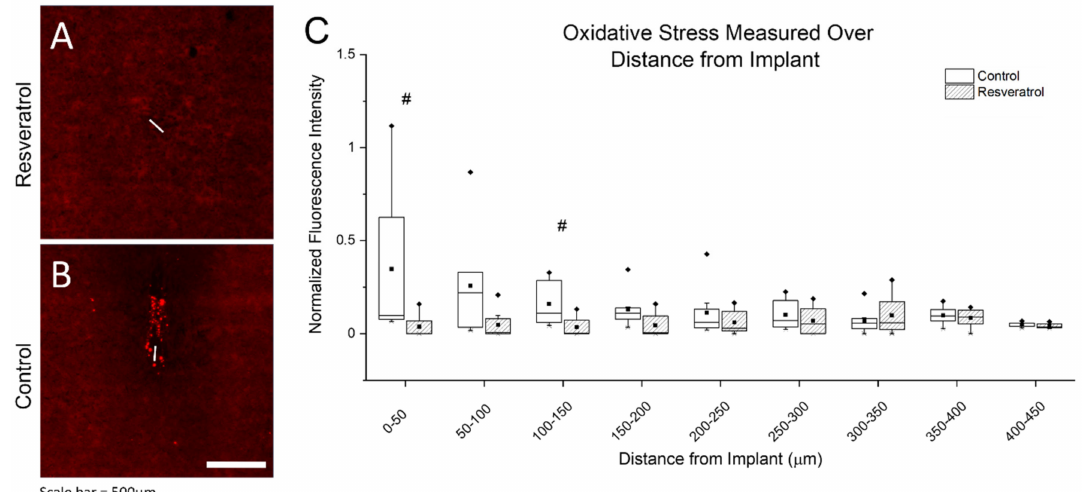
Figure 5. Oxidative stress as measured through protein damage. Representative image of oxidative stress as depicted by oxidized proteins ( A , B ), and normalized fluorescence intensity of analyzed images in bins of 50 mm distances from the electrode implant tract ( C ). There was a significant (# p < 0.05) decrease in nitrotyrosine detected in the resveratrol group compared to the control group at the 0–50 µ m and 100–150 µ m ranges. The white line depicts the electrode implantation site. The whiskers represent the range within 1.5 IQR, the lines inside the boxes represent the median line, the solid squares in the middle represent the mean and the diamonds represent